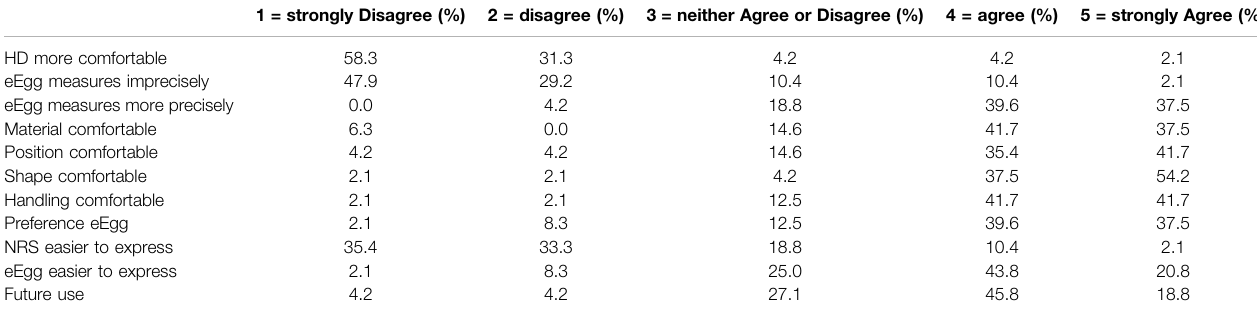
TABLE 4 | Selected results of the online questionnaire N =